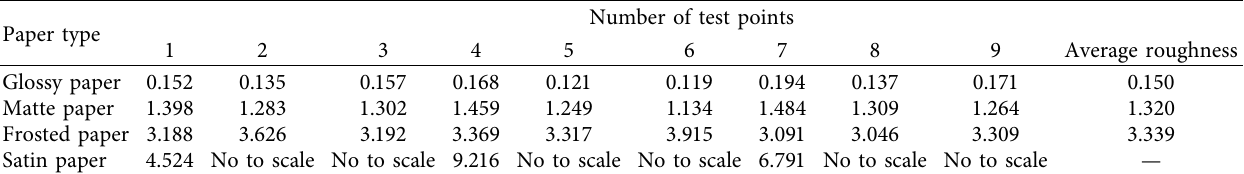
Figure 5: Relationship between the ratio of white endmembers and the extreme reflectance. Table 2: Statistical table of roughness test data (unit: μ